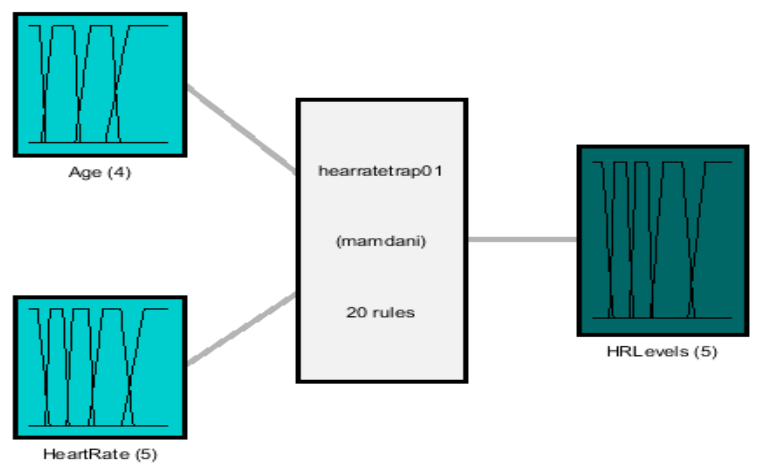
Figure 3. Heart rate level fuzzy system.